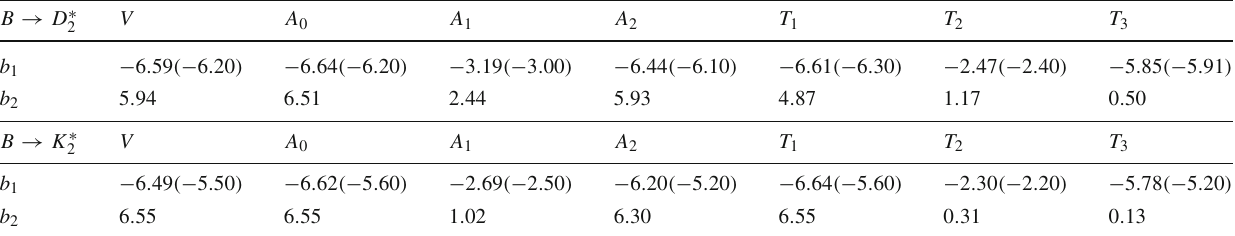
Table 6 The values of b 1 and b 2 for the form factors of B → D ∗ in the parenthesis are the results obtained within the truncation-scheme N =